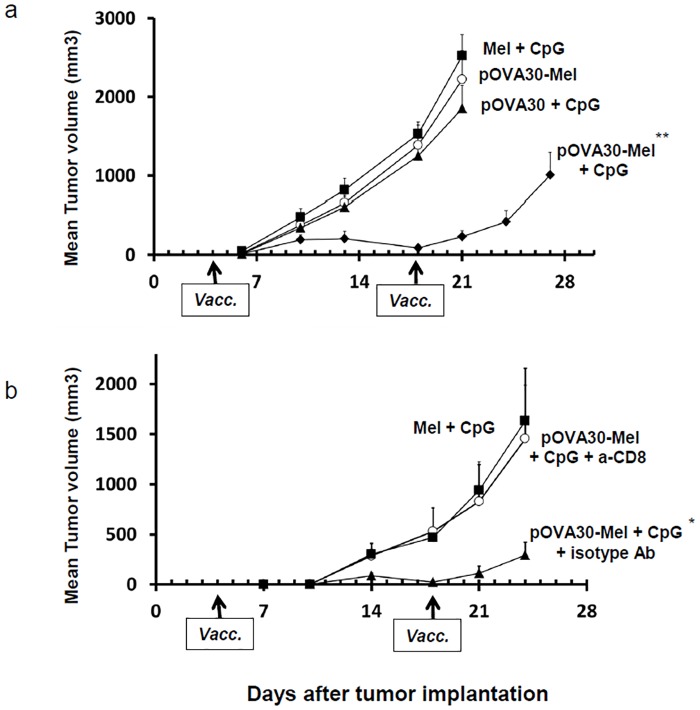
Anti-tumor effect of immunizations in C57BL/6 mice bearing subcutaneous tumors.(a) Mice were injected with E.G7-OVA cells on day 0 and then immunized on days 4 and 18 (arrows) with [pOVA30-melanin + CpG], [melanin + CpG], [pOVA30 + CpG], or [pOVA30-melanin] (n = 10 mice/group with pooled data from two different experiments). (b) Effect of the in vivo CD8 depletion in C57BL/6 mice bearing subcutaneous E.G7-OVA tumors and immunized on days 4 and 18 (arrows) with [melanin + CpG] (n = 4 mice) or [pOVA30-melanin + CpG] (n = 8 mice). The latter group received either anti-CD8 or an isotype-matched control mAb. Tumor growth was assessed twice a week by measuring the size of tumors with calipers. Results are expressed as the mean ± SEM of tumor volumes. * p < 0.05; ** p < 0.001, when compared with control groups.